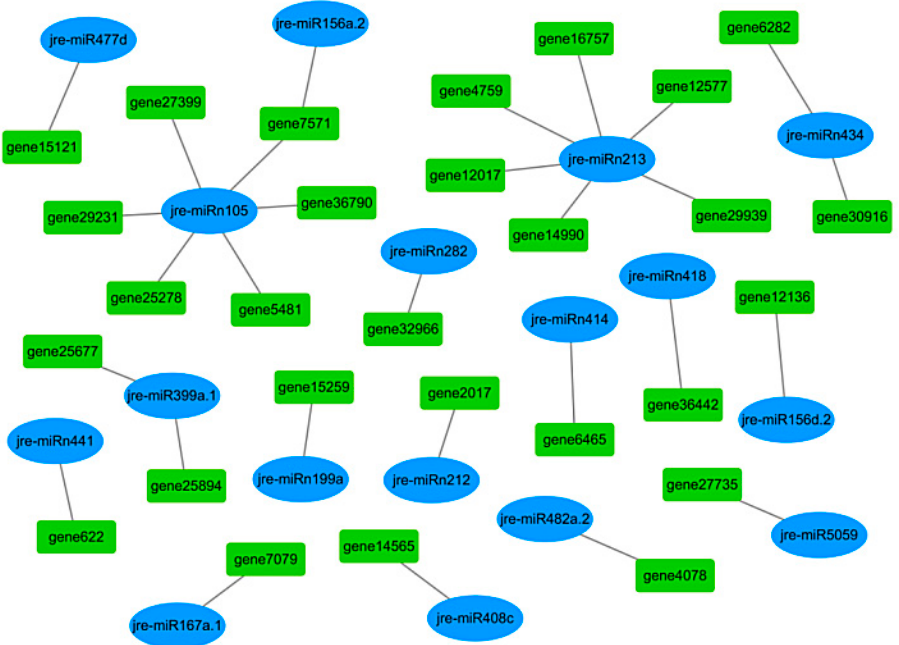
Figure 8. Potential miRNA-mRNA regulatory module is related to oil accumulation during walnut fruit development.